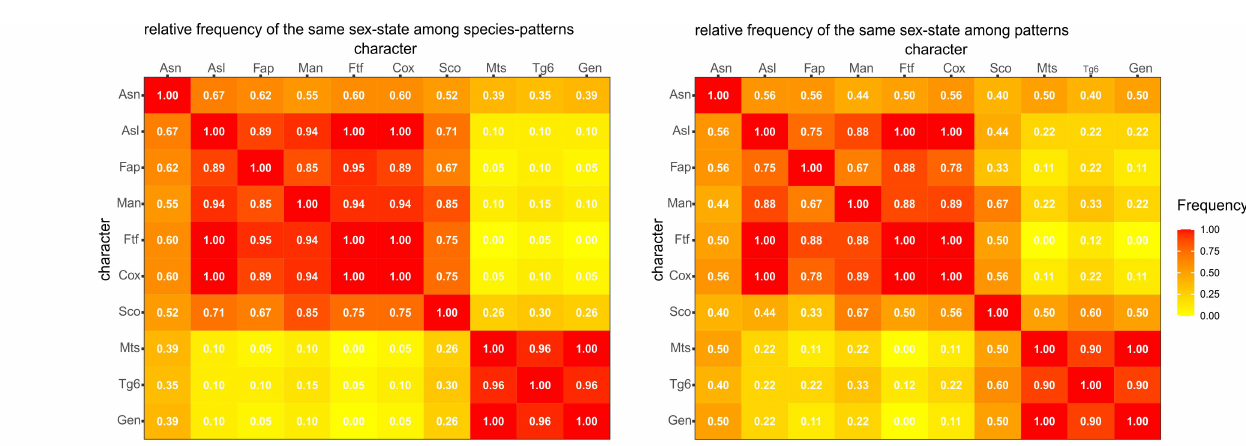
Figure 9. Relative frequency of pairwise sex-state concordance for ten morphological characters (the matrix is symmetric with respect to the main diagonal). Left , species-pattern frequency (sample size varies between 18 and 23, because some species patterns do not cover all the characters; see Figure 1). Right , pattern frequency (sample size varies between 7 and 10, because some patterns do not cover all the characters; see Figure